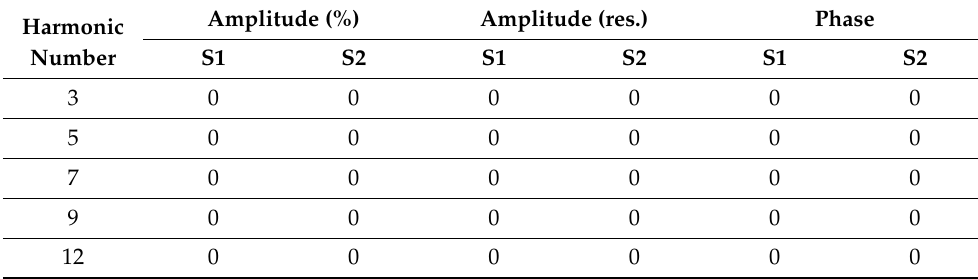
Table 3. AD results for microgrid close-in event distribution as seen by S 1 and S 2